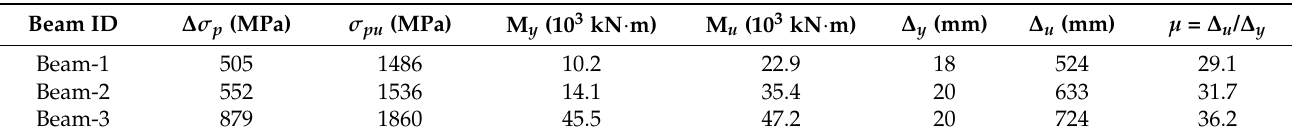
Figure 14. Performance comparisons of PSCB with different prestressing schemes. Table 3. Comparisons of indices for